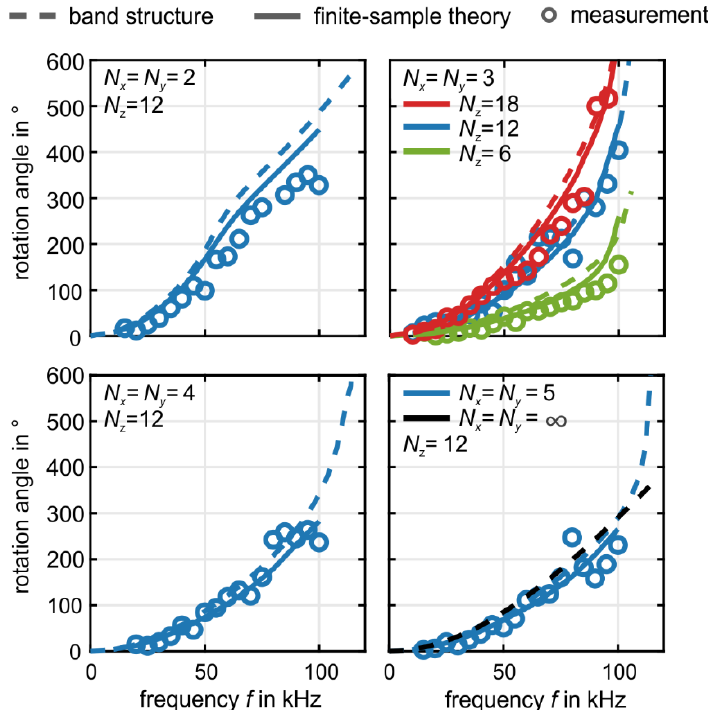
Figure 6. Derived from data like those shown in Figure 5, we plot the rotation angle 𝜑 = 𝜑(𝑓) versus excitation frequency f for different beam cross sections, (𝑁 𝑥 × 𝑁 𝑦 )𝑎 2 , and for different numbers of unit cells, 𝑁 𝑧 , along the propagation direction. The measured results are depicted as circles; the solid curve has been obtained from numerical finite-element frequency-domain calculations for finite-size samples (as in the experiment, cf. Figure 5), accounting for a finite imaginary part of the Young’s modulus 𝐸 (cf. Figure 1); and the dashed curves have been obtained from phonon band-structure calculations (cf. Figure 2), assuming zero imaginary part of 𝐸 . In the upper right-hand side panel, we vary 𝑁 𝑧 at fixed 𝑁 𝑥 = 𝑁 𝑦 . In the lower right-hand side panel, we show by the dashed black curve the expectation for the bulk limit, obtained from phonon band-structure calculations, again with zero imaginary part of 𝐸 . Obviously, the 𝑁 𝑥 × 𝑁 𝑦 = 5 × 5 case (blue) is already very close to the bulk limit (dashed back curve). At around 𝑓 = 100 kHz , we obtain a polarization rotation as large as about 30° per lattice